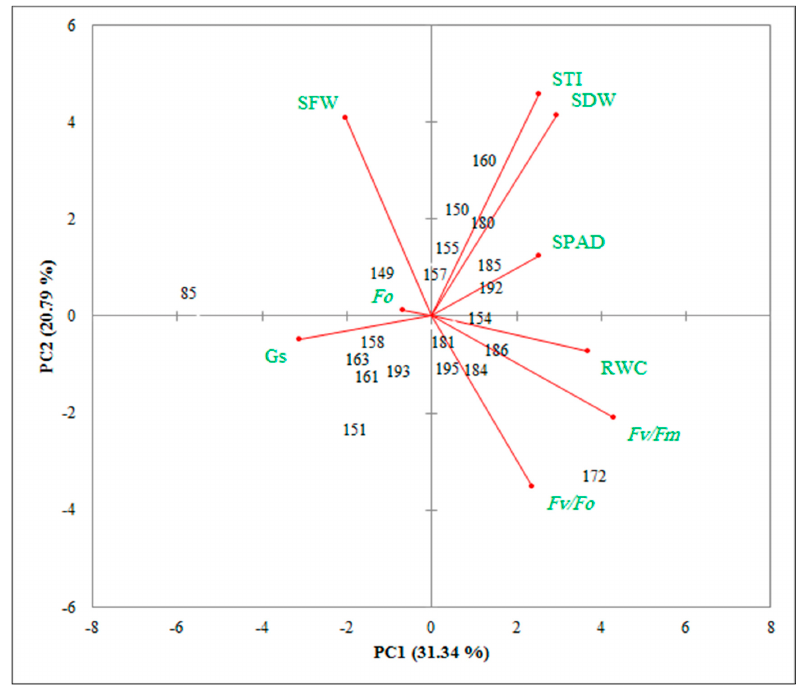
Figure 6. Biplot of the different physio-chemical traits, shoot biomass-related traits, and STI of Ae. crassa accessions under the water deficit stress condition. SPAD, Gs, Fo, Fv/Fo, Fv/Fm, SFW, SDW and STI indicate the relative chlorophyll content, stomatal conductance, initial fluorescence, maximum primary yield of photochemistry, maximum quantum efficiency, shoot fresh weight, shoot dry weight and stress tolerance index, respectively.